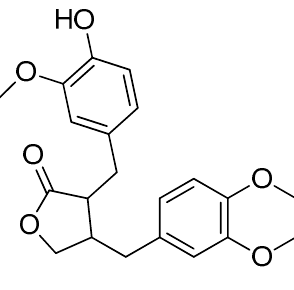
Figure 21. Arctigenin.